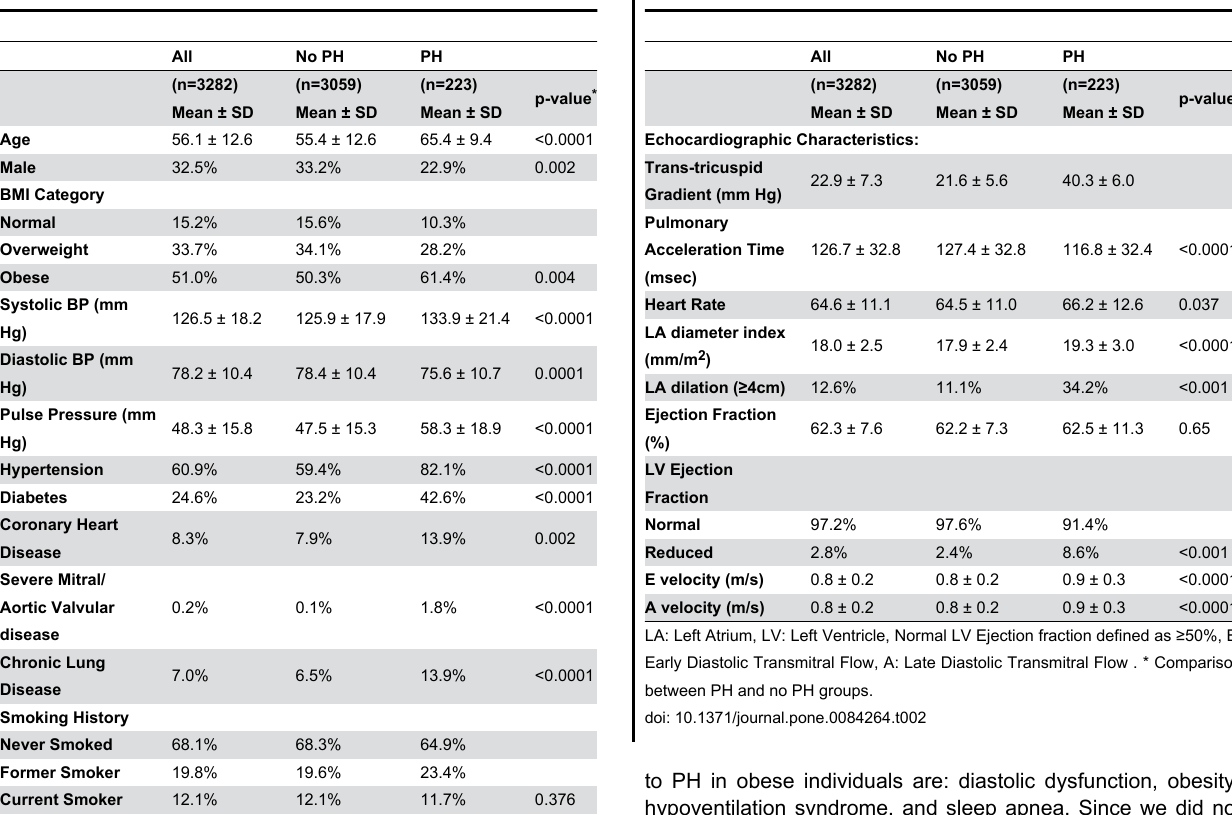
Table 1. Baseline Characteristics:. Table 2. Echocardiographic